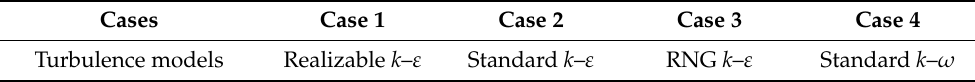
Table 1. Simulation cases with different turbulent